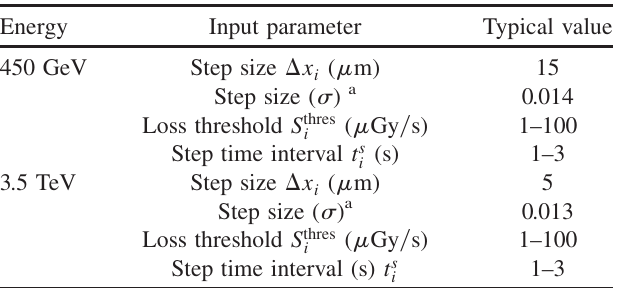
TABLE IV. Examples of algorithm inputs based on experience with the alignment. The inputs depend on the beam energy and the steady-state level of the BLM signal.